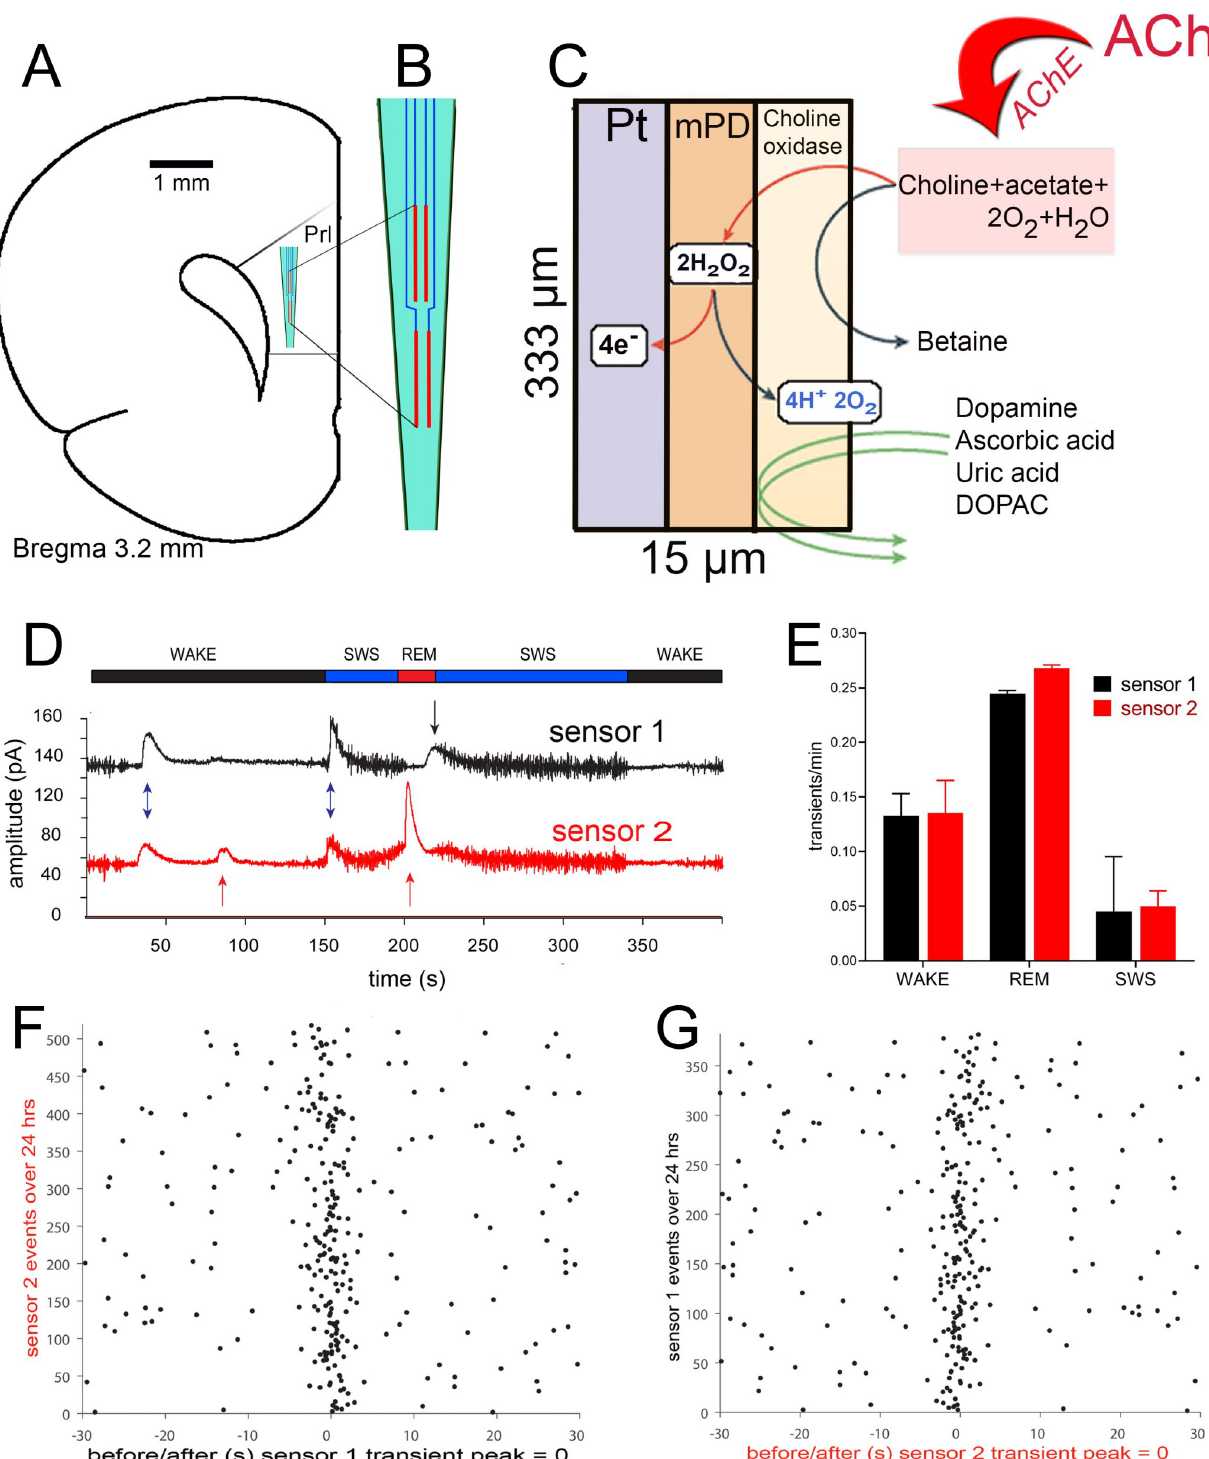
Fig 1. Spatial localization and asynchronicity of cholinergic signals. Cholinergic signaling is largely asynchronous and can influence target circuitry in a temporally and spatially highly heterogenous manner. Data recorded in prelimbic cortex ( A ) are shown here. The four platinum (Pt) recording sites fabricated onto a ceramic backbone electrode are illustrated in B and the placement of these recording sites in prelimbic cortex are shown in A . C depicts the dimensions of an individual recording site. The upper and lower pairs of recording sites were separated by 100 μ m. The data shown in D-G were recorded via an upper sensor (“sensor 1) and a lower sensor (“sensor 2”). The neurochemical recording scheme, shown in C, was previously described in